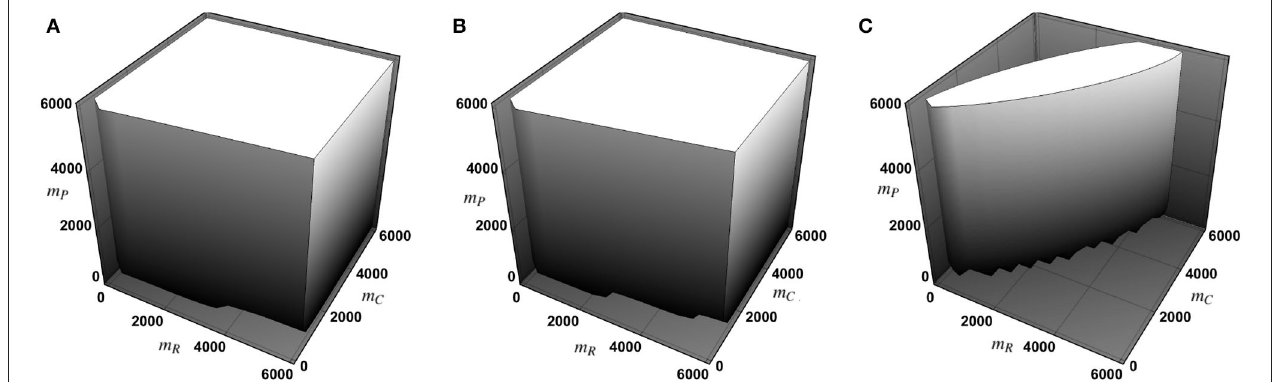
FIGURE 2 | Conditions of coexistence and global stability R C ( K ) > 1 and R P ( C ∗ ) > 1 in terms of body sizes m R , m C and m P . (A) With allometric exponent α r = 2 / 3 (surface law), γ = 3 / 4 and β = 1 / 2. (B) With allometric exponent α r = 3 / 4 (Kleiber’s law), γ = 3 / 4 and β = 1 / 2. (C) With allometric exponent α r = 1 (isometry), γ = 3 / 4 and β = 1 / 2. The other parameter values are: r 0 = 0.5, K 0 = 5, e C = 0.5, e P = 0.5, d C = 0.74, d P = 0.74, f